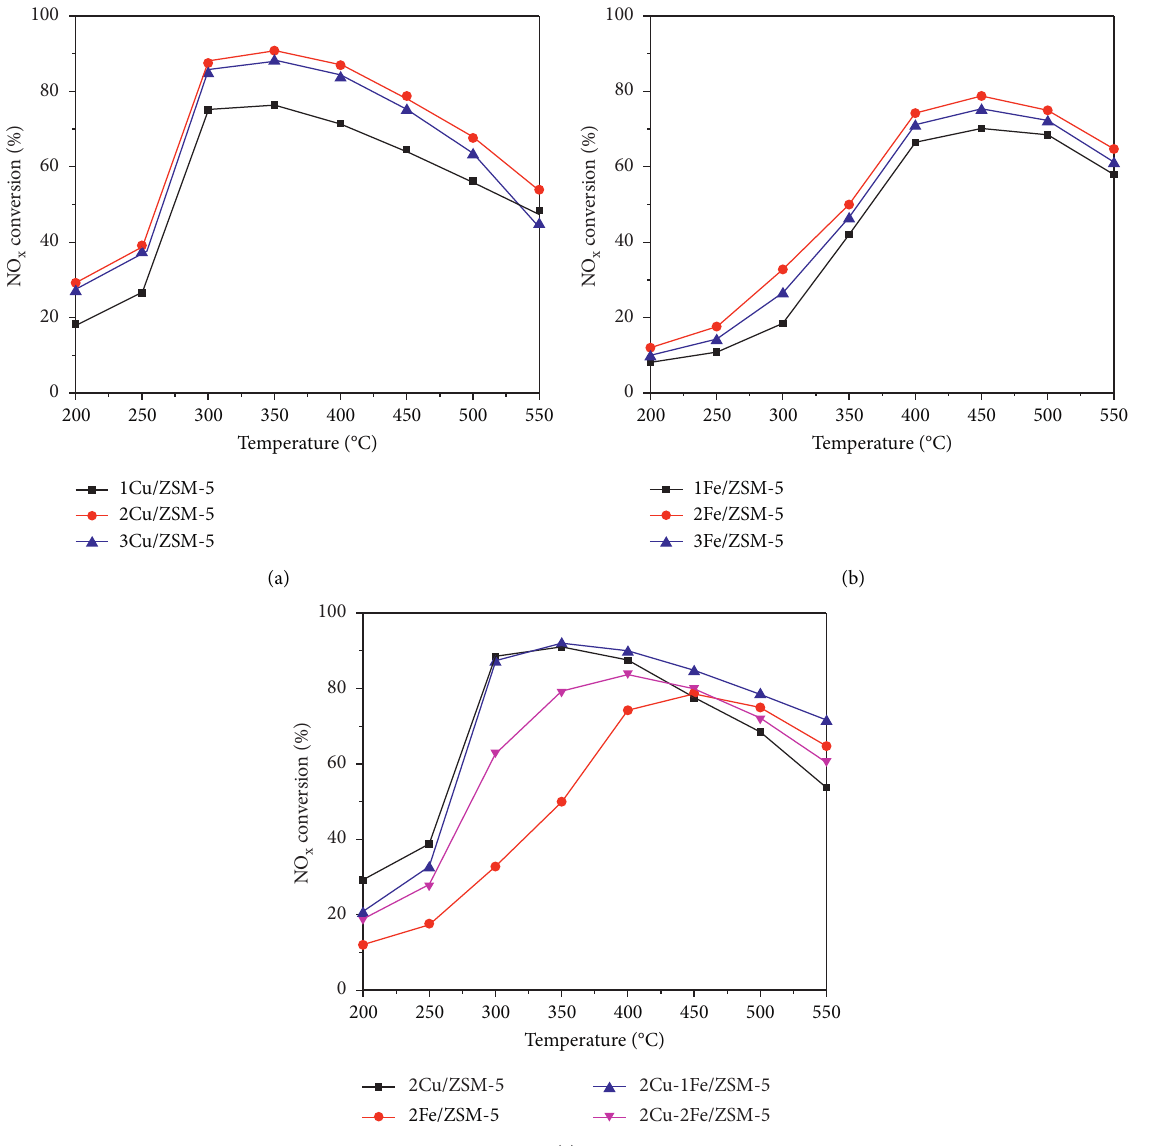
Figure 9: NO x conversion during standard NH 3 -SCR as a function temperature of (a) Cu/ZSM-5, (b) Fe/ZSM-5, and (c)